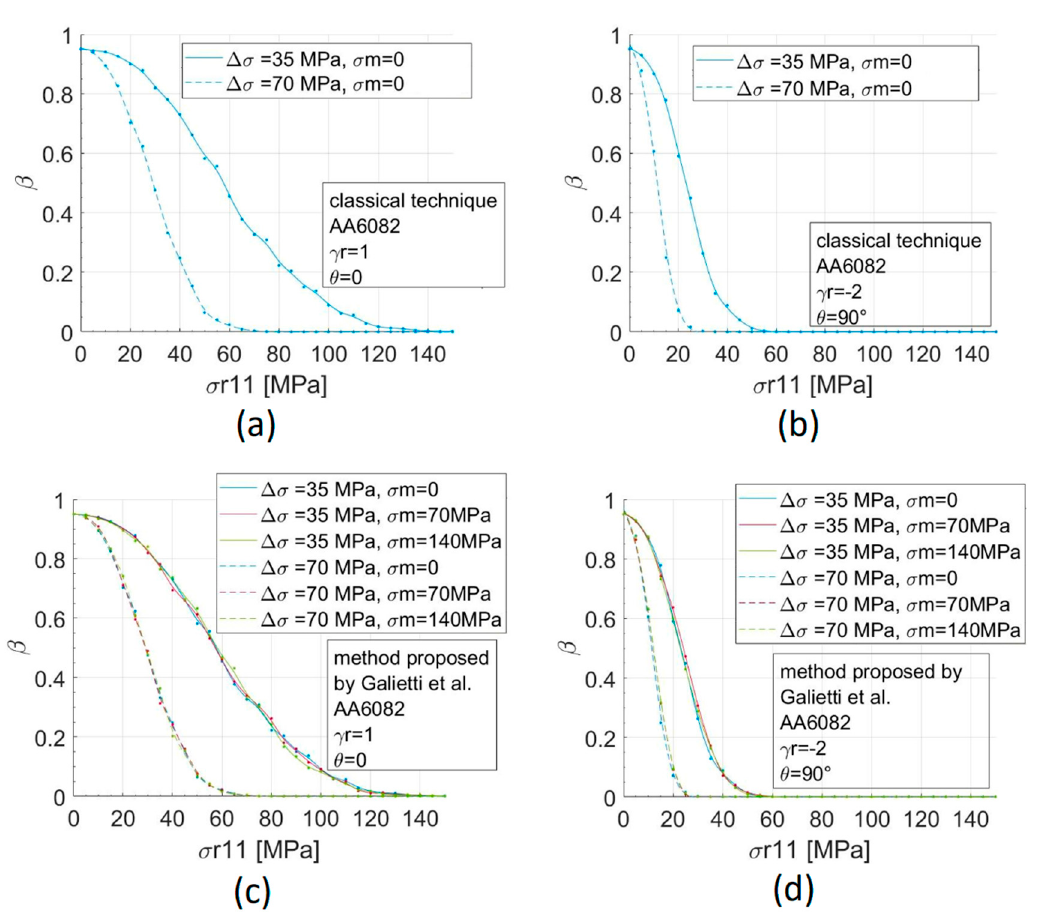
Figure 8. Second type error as function of σ r11 for the AA6082 alloy: The classical technique and the method proposed in Reference [17] are compered for the case of ( a , c ) for low and ( b , d ) for high residual stresses effect.